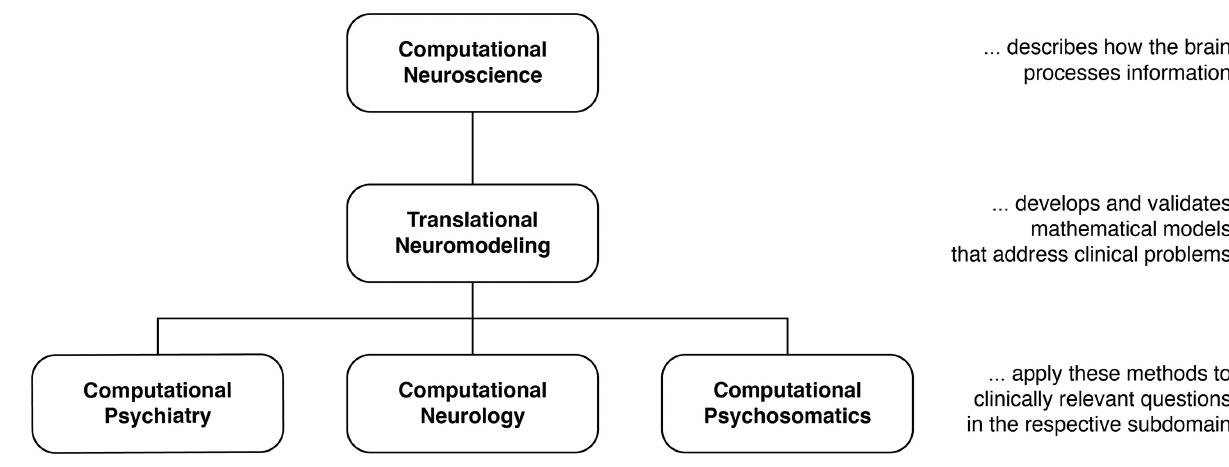
FIGURE 1 | Taxonomy for different disciplines in the computational neurosciences and their relation to clinical questions. Translational Neuromodeling (TN) develops and validates mathematical models for addressing clinical problems, whereas Computational Psychiatry (CP), Neurology (CN), and Psychosomatics (CPS) then apply these methods to clinically relevant questions. Reprinted with permission from Frässle et al. (13). Copyright 2018